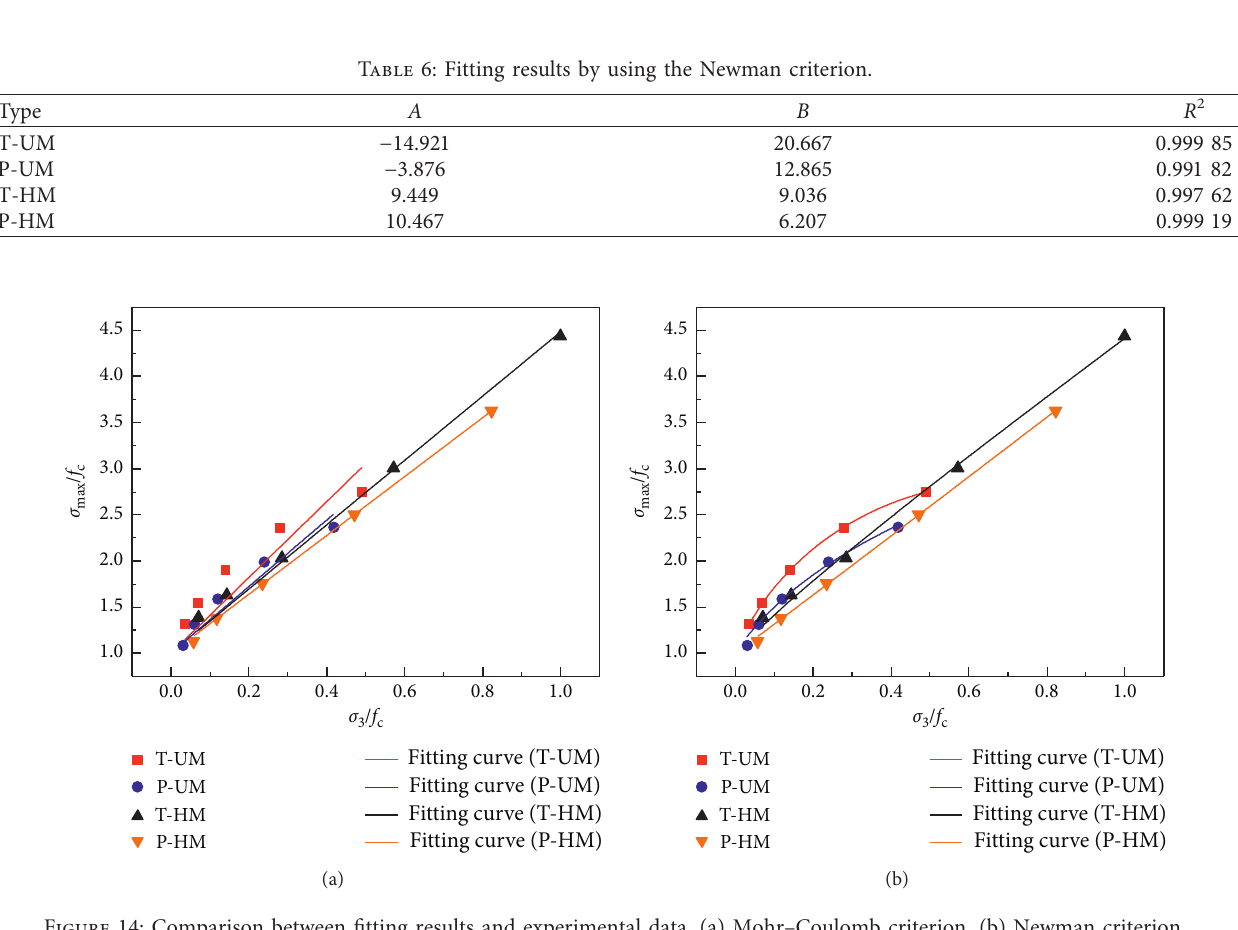
Figure 14: Comparison between fitting results and experimental data. (a) Mohr–Coulomb criterion. (b) Newman criterion.